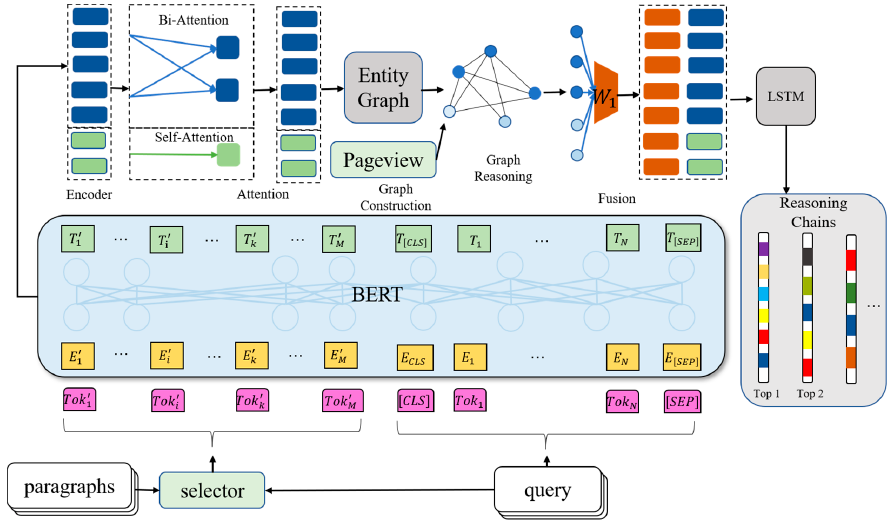
Figure 4. Model architecture of the proposed 2SCR-IR sensor.